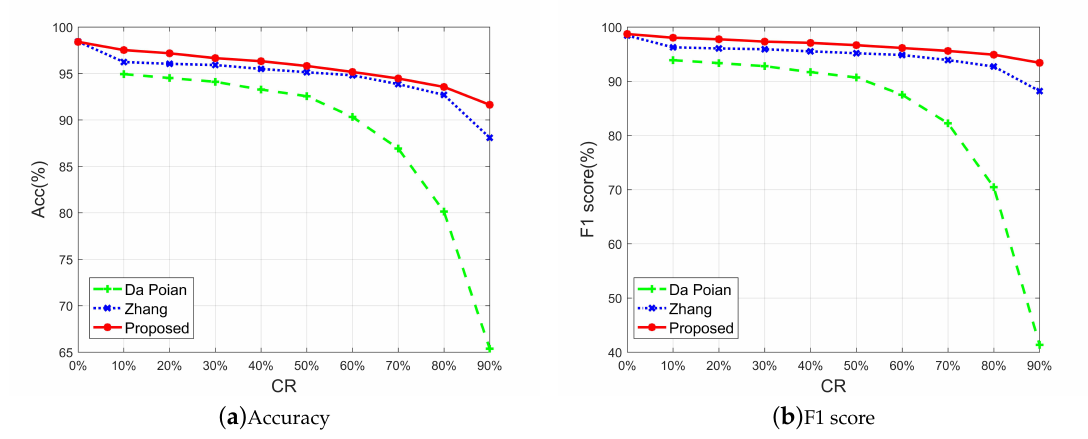
Figure 5. Comparison of accuracy and F1 score of three methods at different compression